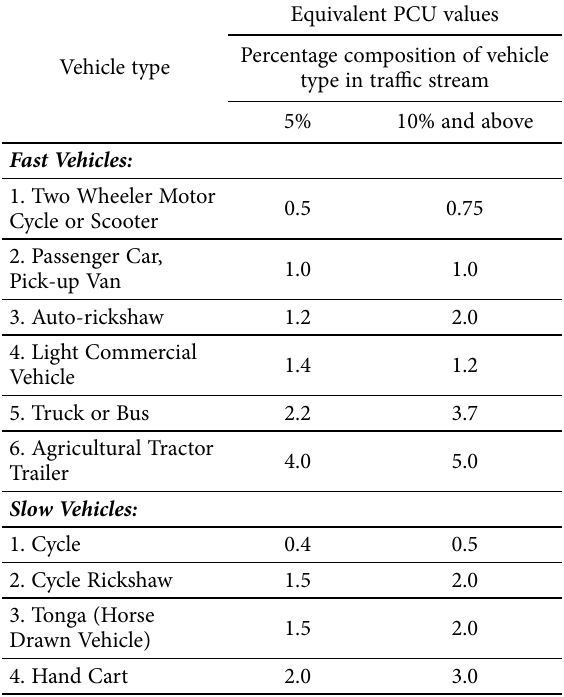
Table 2. Recommended PCU values of vehicles on urban roads by IRC